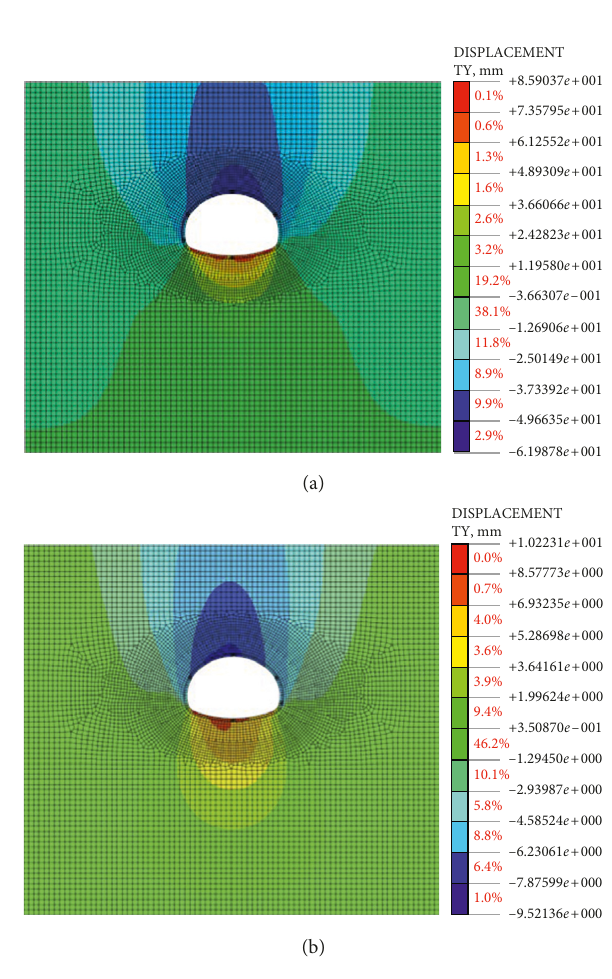
Figure 3: Vertical displacement under two